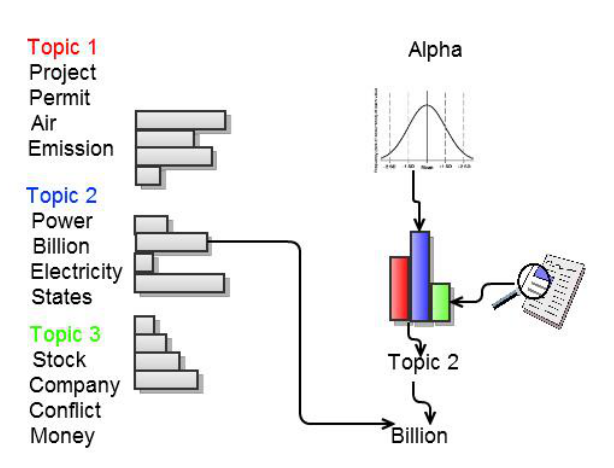
Figure 3. LDA’s generative model illustrated with 3 topics and four